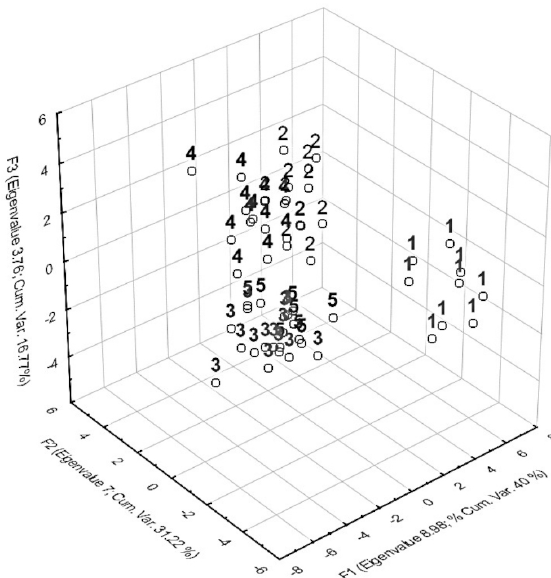
Figure 3 - Visualization space for Discriminant Analysis of Principal Component (DAPC). On the three first resultant factors (F1, F2 and F3) with the eigenvalues and the cumulative variance (%), of the five populations from Mexico of Dicrocoelium rileyi (Durango = 1 ; Mexico State = 5 ; Nuevo Leon = 3 ; Puebla = 2 ; Zacatecas = 4 ) parasitizing Tadarida brasiliensis